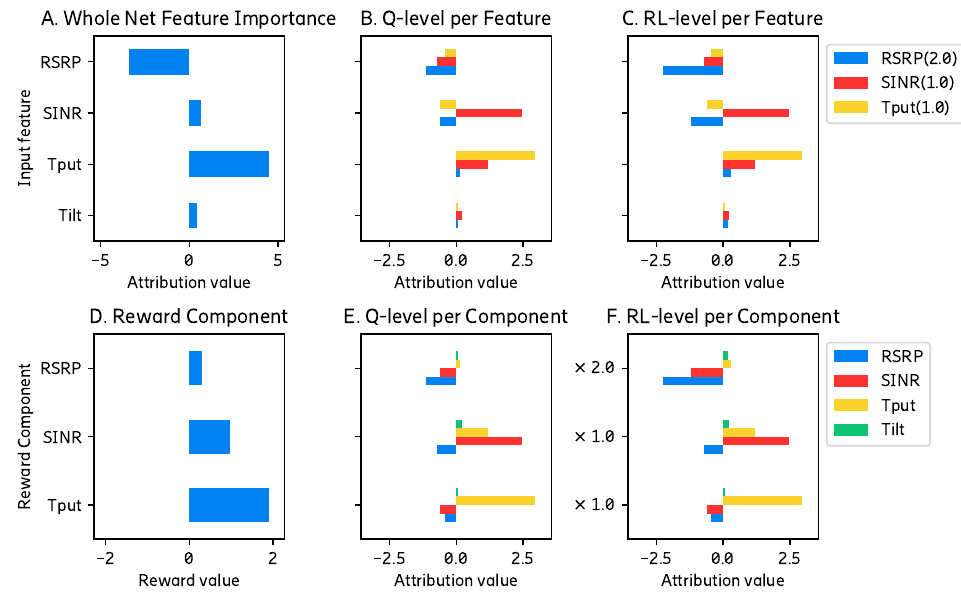
Figure 8. The local explanations of one antenna when the agent chose no-tilt action.